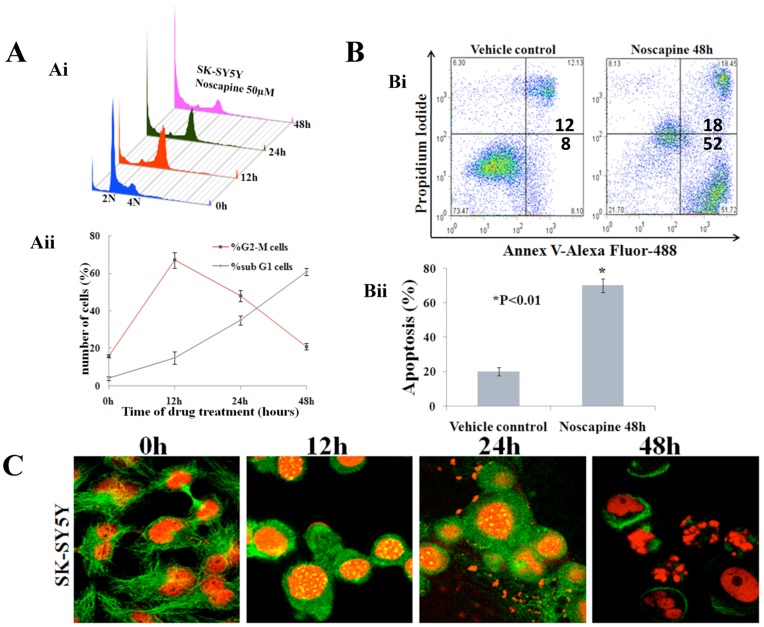
Noscapine perturbs cell-cycle progression of Sk-SY5Y cells and cause apoptosis.
A. Effect of 25 µM EM011 on cell-cycle progression of A549 cells over time shown in a three-dimensional disposition. X-axis, intensity of propidium iodide fluorescence, is indicative of the total DNA content of cells in various phases of the cell-cycle. Y-axis, number of cells detected for a given DNA content. Z-axis, time points (i.e., 0, 12, 24, and 48 hrs). Representative results of three independent experiments. B. Quantitative graphical representation of the percentage of G2/M and sub-G1 cell population. Points, average of three independent experiments; bars, SD (p<0.05). C. Confocal immunofluorescence analyses of cells. Microtubules and DNA were visualized using fluorescent anti-alpha-tubulin antibody (green) and fluorescent DNA dye propidium iodide (red). SK-SY5Y cells begin to show mitotic arrest as early as 12 hours after drug treatment and begin to show disorganized arrest and chromatin decondensation or even death at 48 hours of treatment.